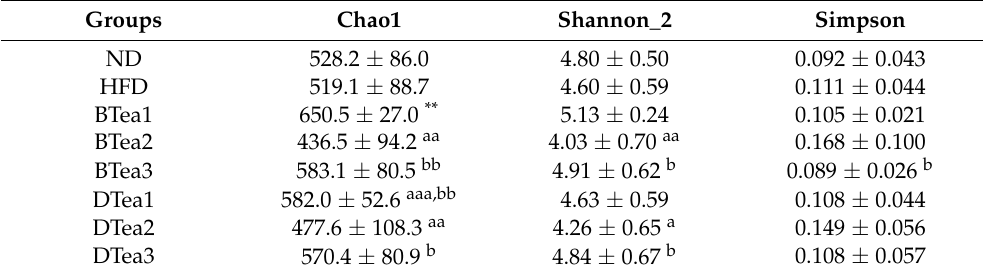
Table 2. Effect of different black and dark teas on gut microbial richness and